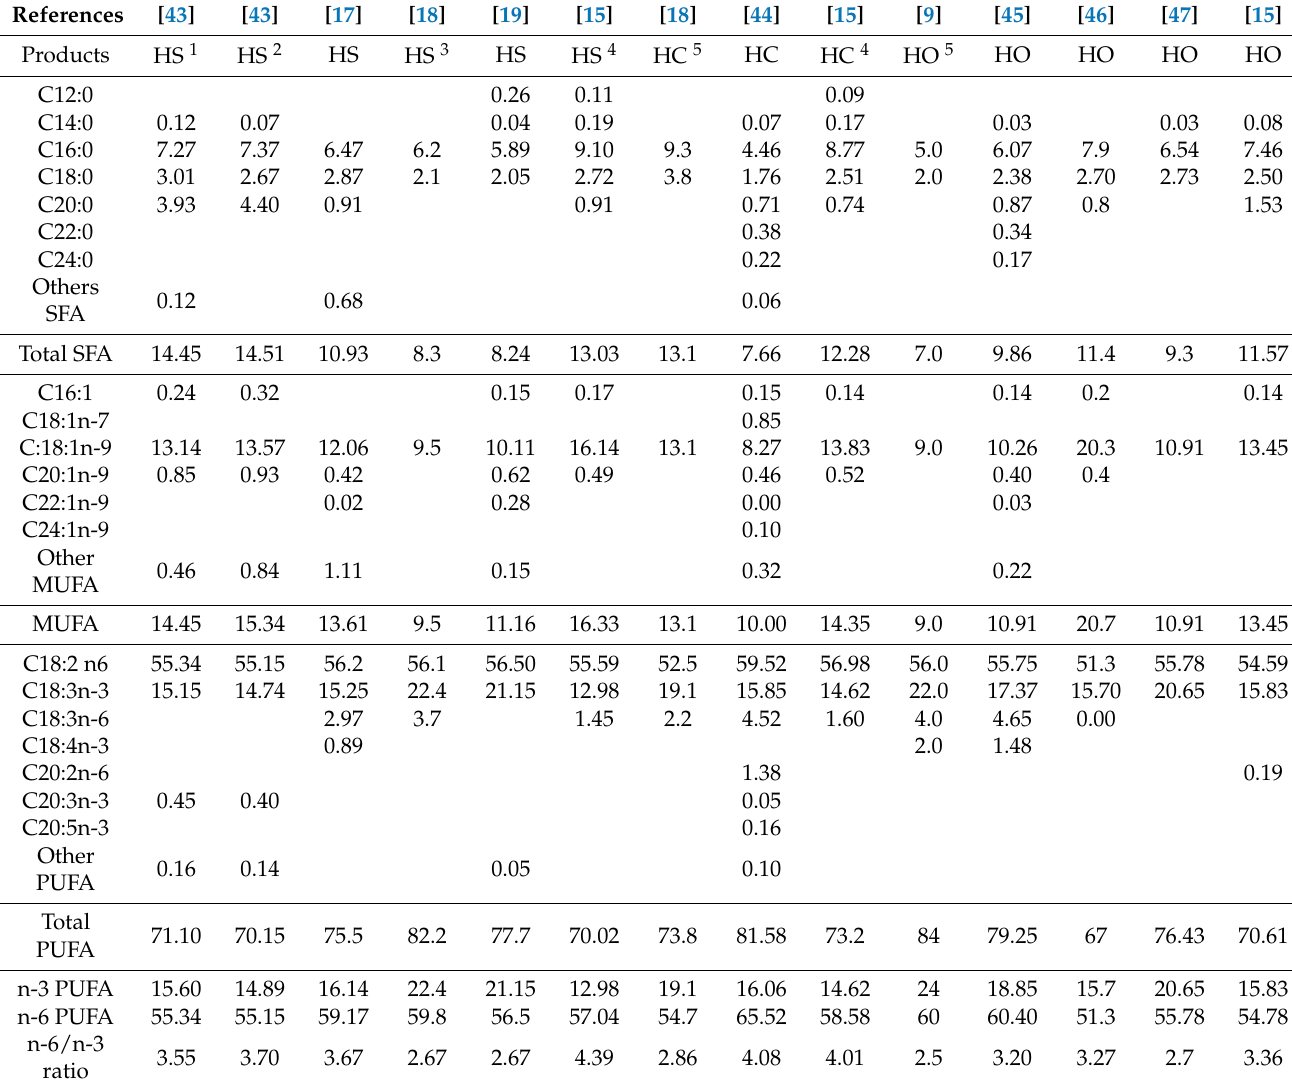
Table 3. Fatty acid profile (% of total FA) of lipids contained in whole hempseed (HS), hemp cake (HC) and hemp oil